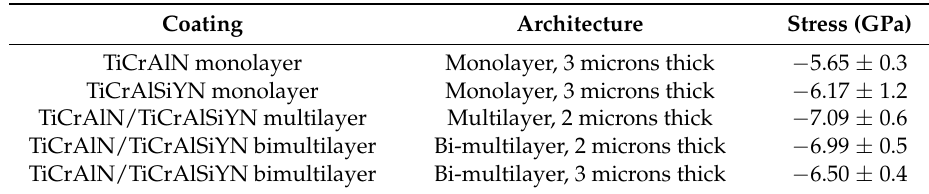
Table 2. Residual stress values in the studied